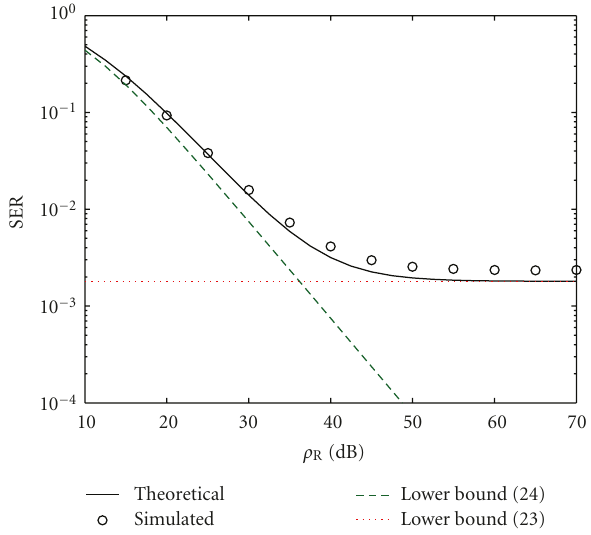
Figure 7: SER in OFDM systems (16-QAM, K = 128, L = 16, ideal